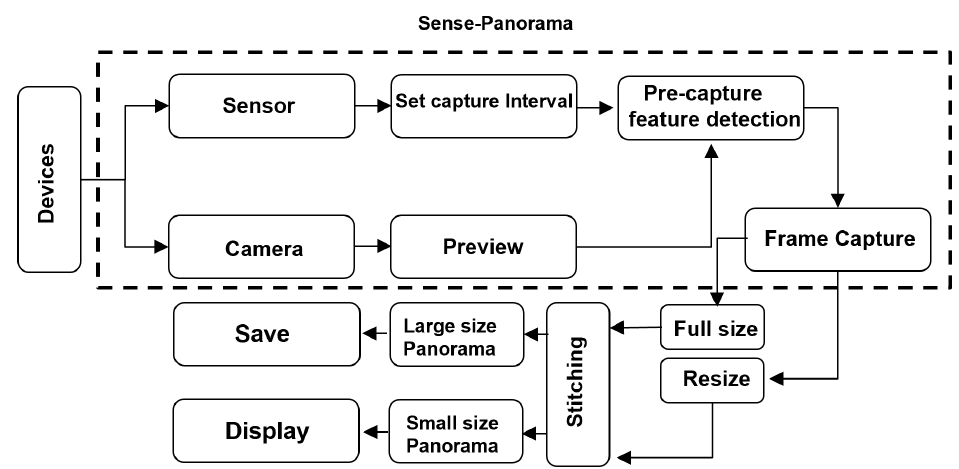
Figure 4. The control flow of the Sense-Panorama method.